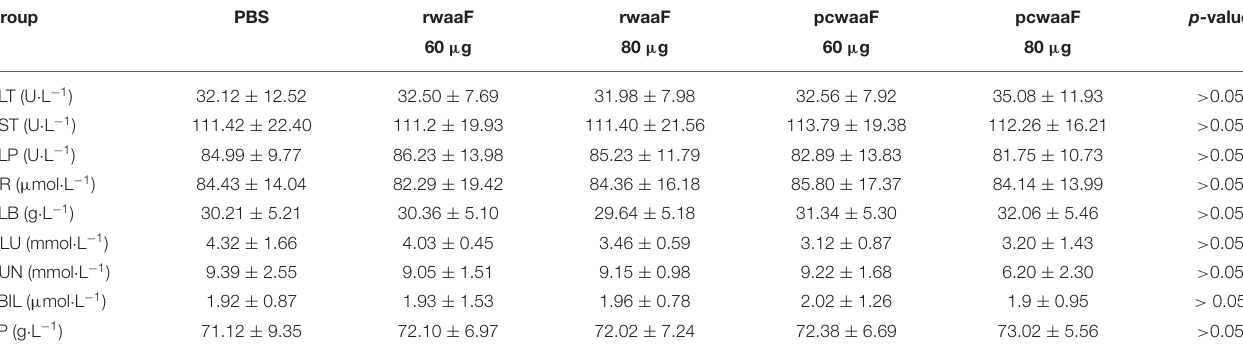
TABLE 5 | The results of Serum biochemical in vaccinated BALB/c mice which were vaccinated rwaaF (60 and 80 µ g), pcwaaF (60 and 80 µ g), and PBS, respectively.